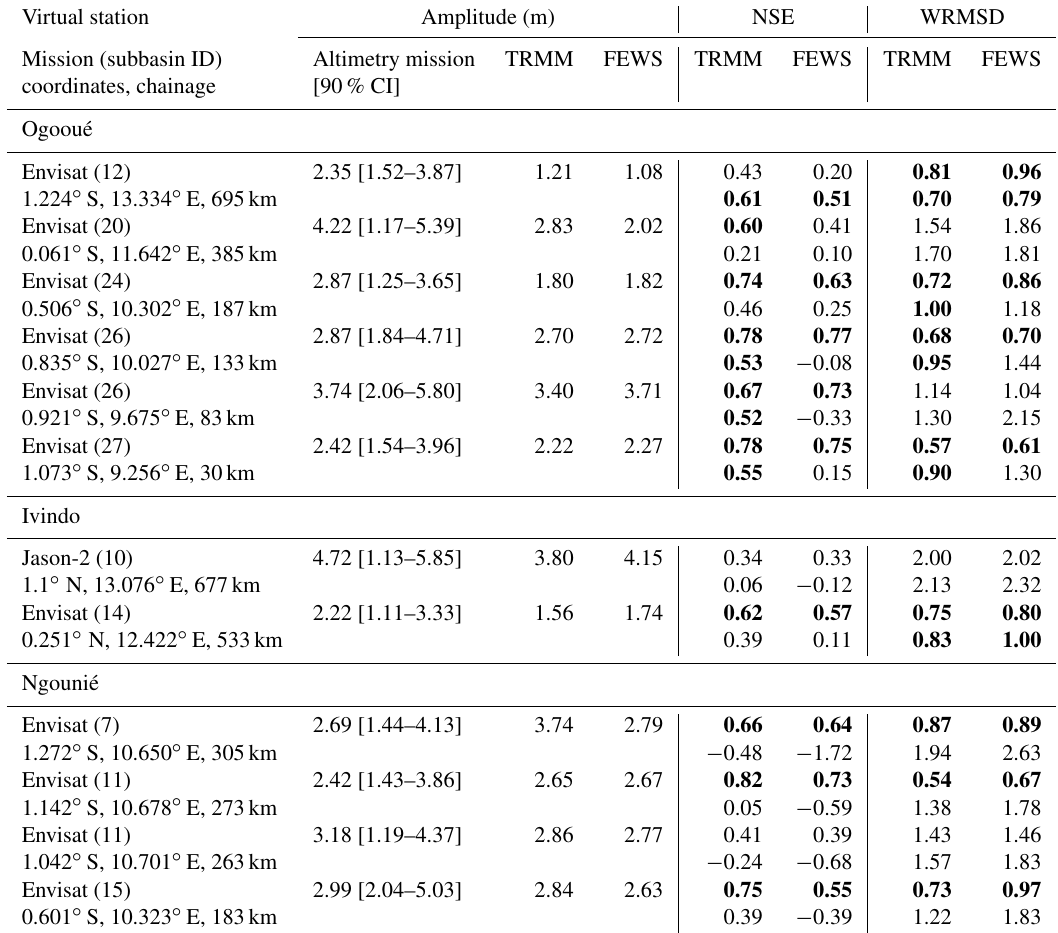
Table 6. Performance statistics for altimetry at virtual stations. The values in parentheses indicate the model subbasin (Fig. 1). The first line shows the statistics for the calibration period and the second for the validation period. Values in bold are within the validation criteria (NSE > 0.5, WRMSD ≤ 1).